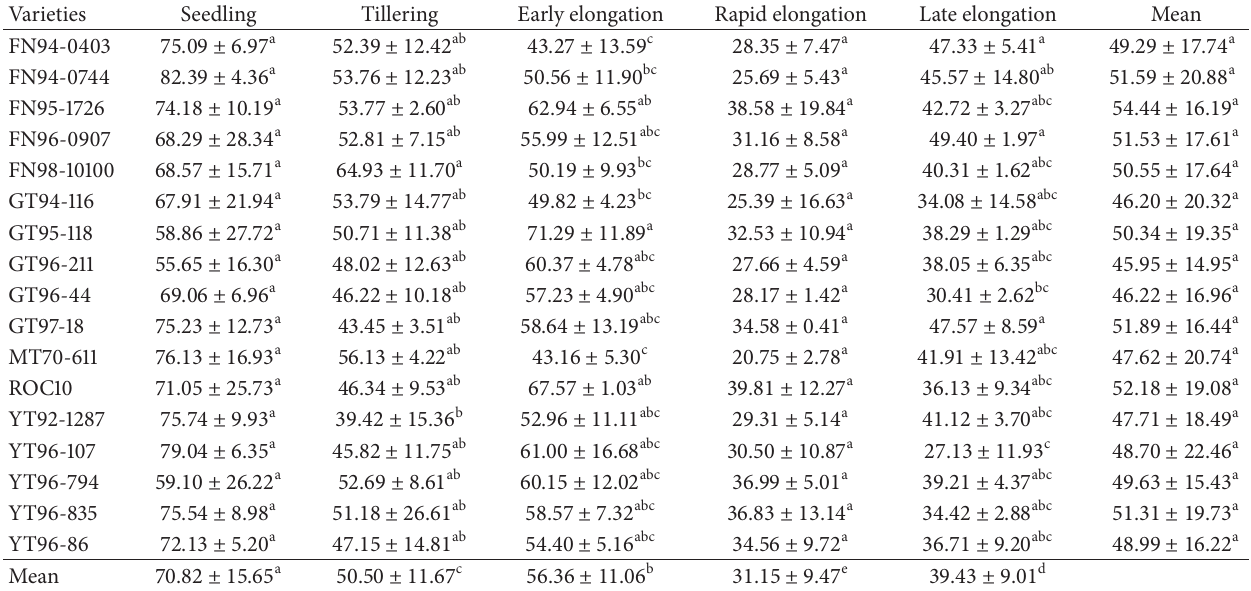
Notes: the lowercase letters denote significant differences at the level of 0.05. Table 2: Seasonal changes of mean foliage inclination angle in sugarcane